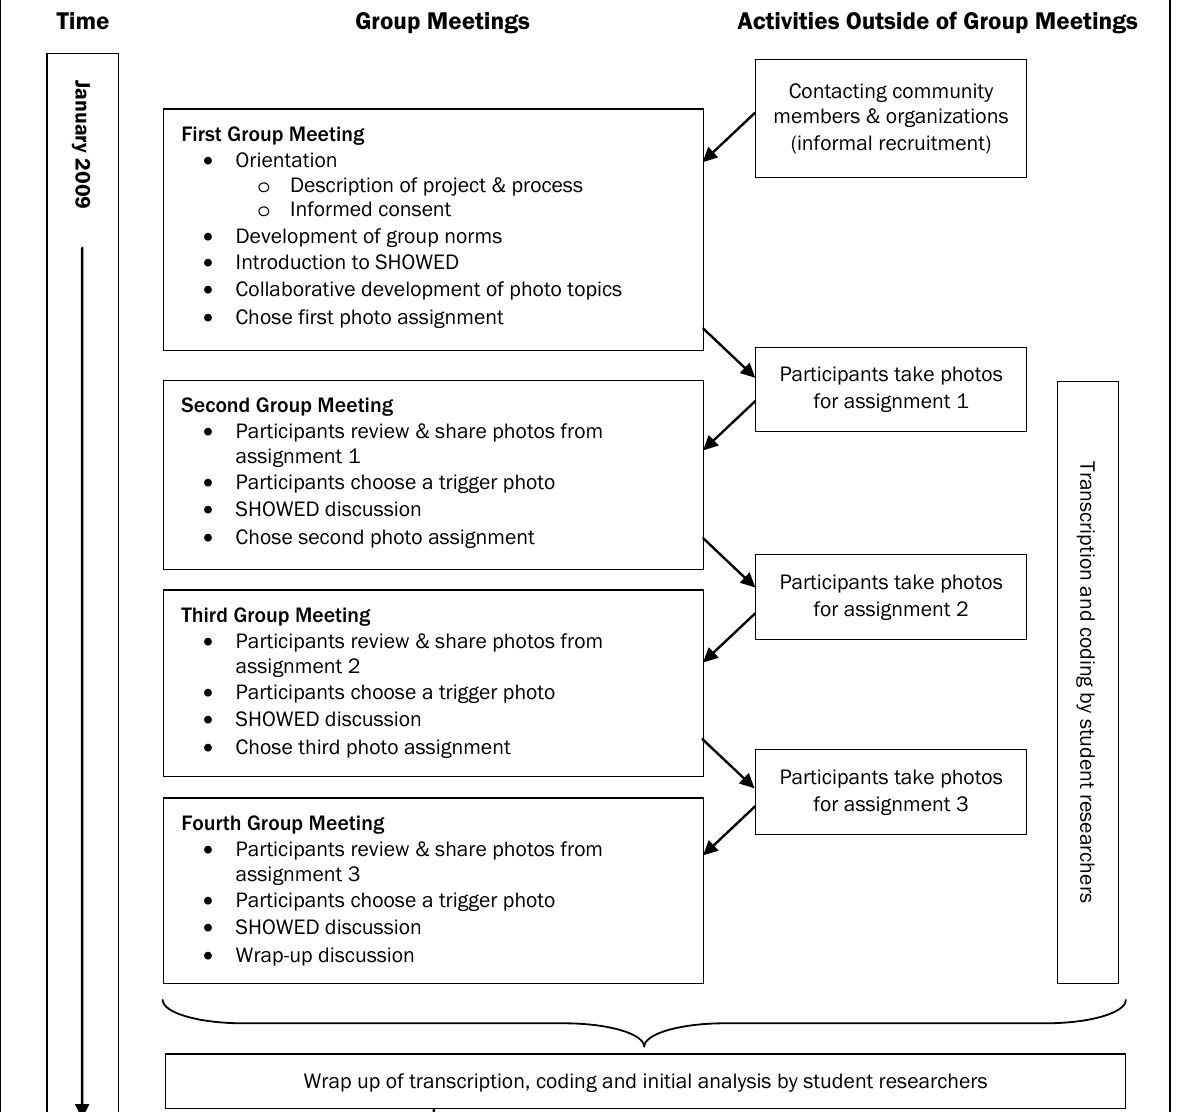
Figure 1. Depiction of Study Activities and Procedure using Photovoice